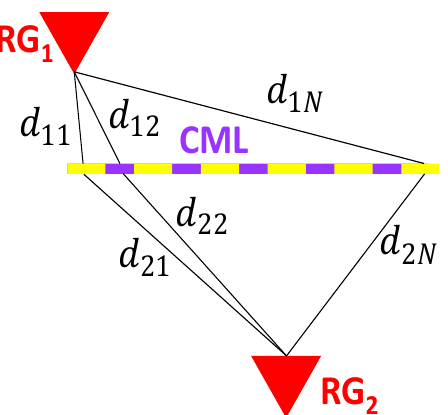
Figure 3. Effective distance of an RG from a